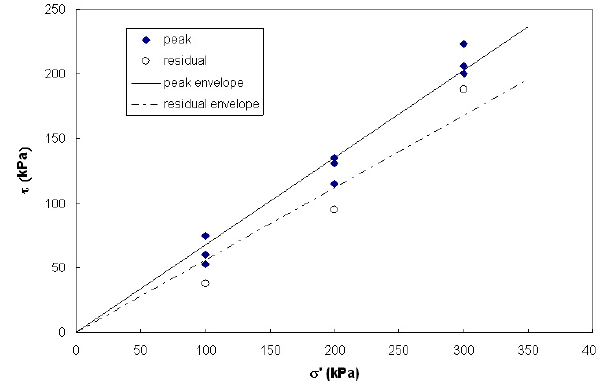
Fig. 9. Peak and residual shear failure envelopes for gneissic cover